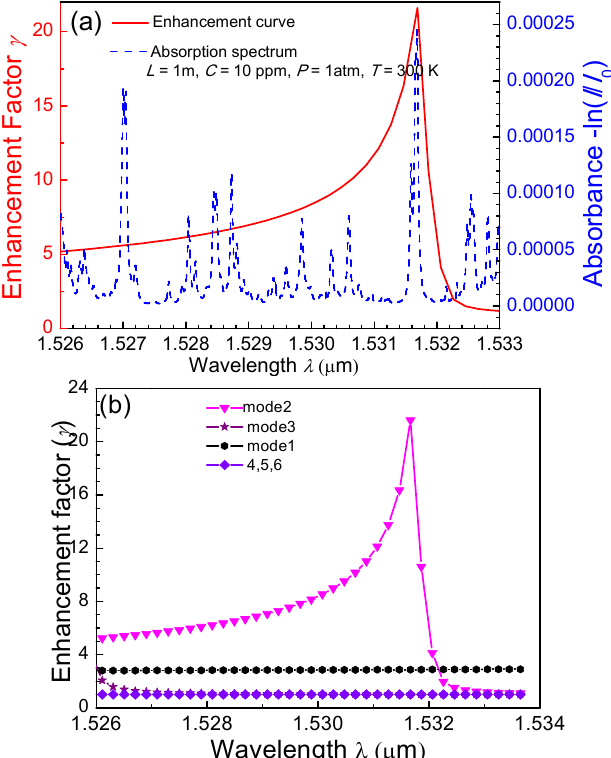
Figure 6. The relationship between the enhanced absorption wavelength and the refractive index of the infiltrated liquid for ( a ) mode 2 and ( b ) mode 3.